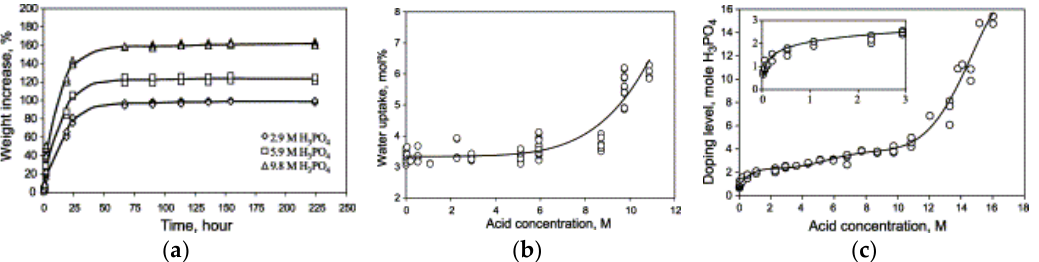
Figure 11. Weight increase as a function of time ( a ); water uptake ( b ); acid doping level of acid-doped PBI membranes at room temperature ( c ). Reprinted with permission from Ref. [100]. Copyright 2004 Elsevier.